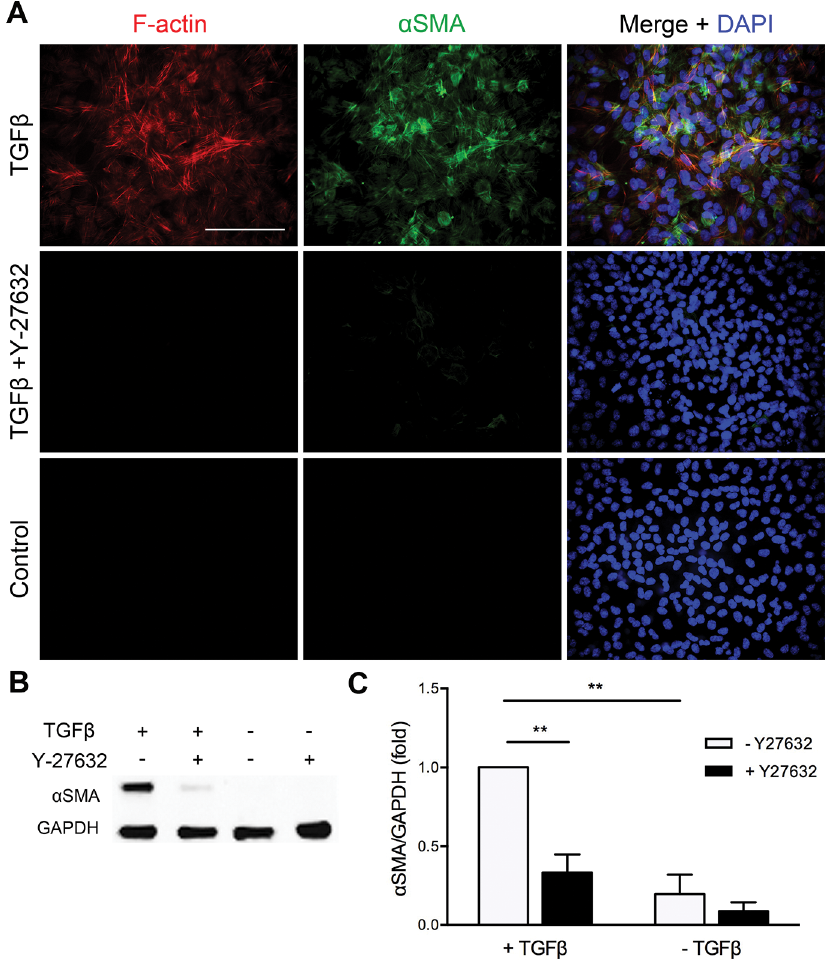
Figure 2. TGF β -induced actin polymerization and induction in α SMA expression are ROCK-dependent. (A) Lens explants were treated with TGF β (4 ng/mL) in the presence and absence of Y-27632 (20 μ M) for 72 h. Fixed explants were costained for F-actin and α SMA and mounted in medium with DAPI to colocalize nuclei. (B) Western blots of pooled lens explant lysates (n ≥ 5 explants per sample) were probed for α SMA, with GAPDH as loading control. (C) Densitometric quantification of α SMA/GAPDH protein indicating the fold reduction in α SMA expression normalized to TGF β -treated explants. Data expressed as the means ± SEM from four separate experiments (** p <.0001). Scale bar = 100 μ m